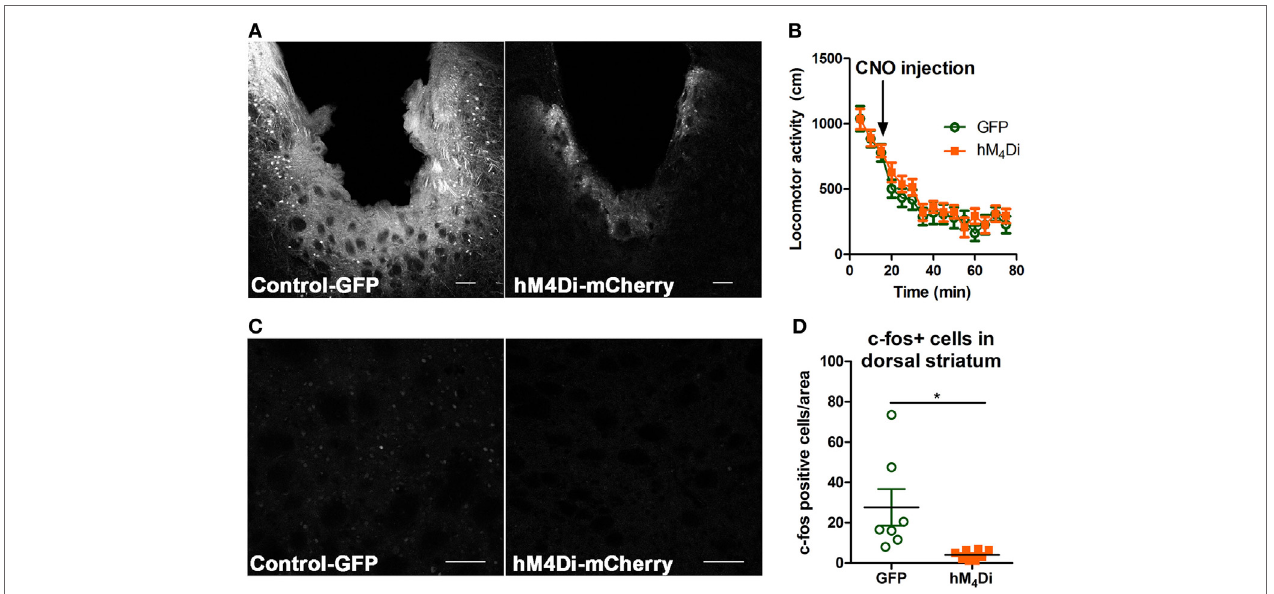
FigUre 2 | Verification of viral expression and functionality of control-GFP or hM 4 Di-mCherry in the dorsal striatum. Viral expression verification via confocal microscopy of control-GFP (left) and hM 4 Di-mCherry (right) in the dorsal striatum (scale bar = 100 µm) (a) . C57BL/6 mice ( n = 10–11 per group) expressing GFP or hM 4 Di in the dorsal striatum did not display significant clozapine- N -oxide (CNO) (2 mg/kg, i.p.) induced locomotor activity in the 60-min session after CNO injection (B) . Immunohistochemical representation of c-Fos activation in the dorsal striatum in animals expressing control-GFP (left) and hM 4 Di-mCherry (right) in the dorsal striatum (scale bar = 100 µm) (c) . Decreased c-Fos expression in dorsal striatum after cocaine challenge (15 mg/kg, i.p.) in C57BL/6 mice ( n = 7–8) expressing